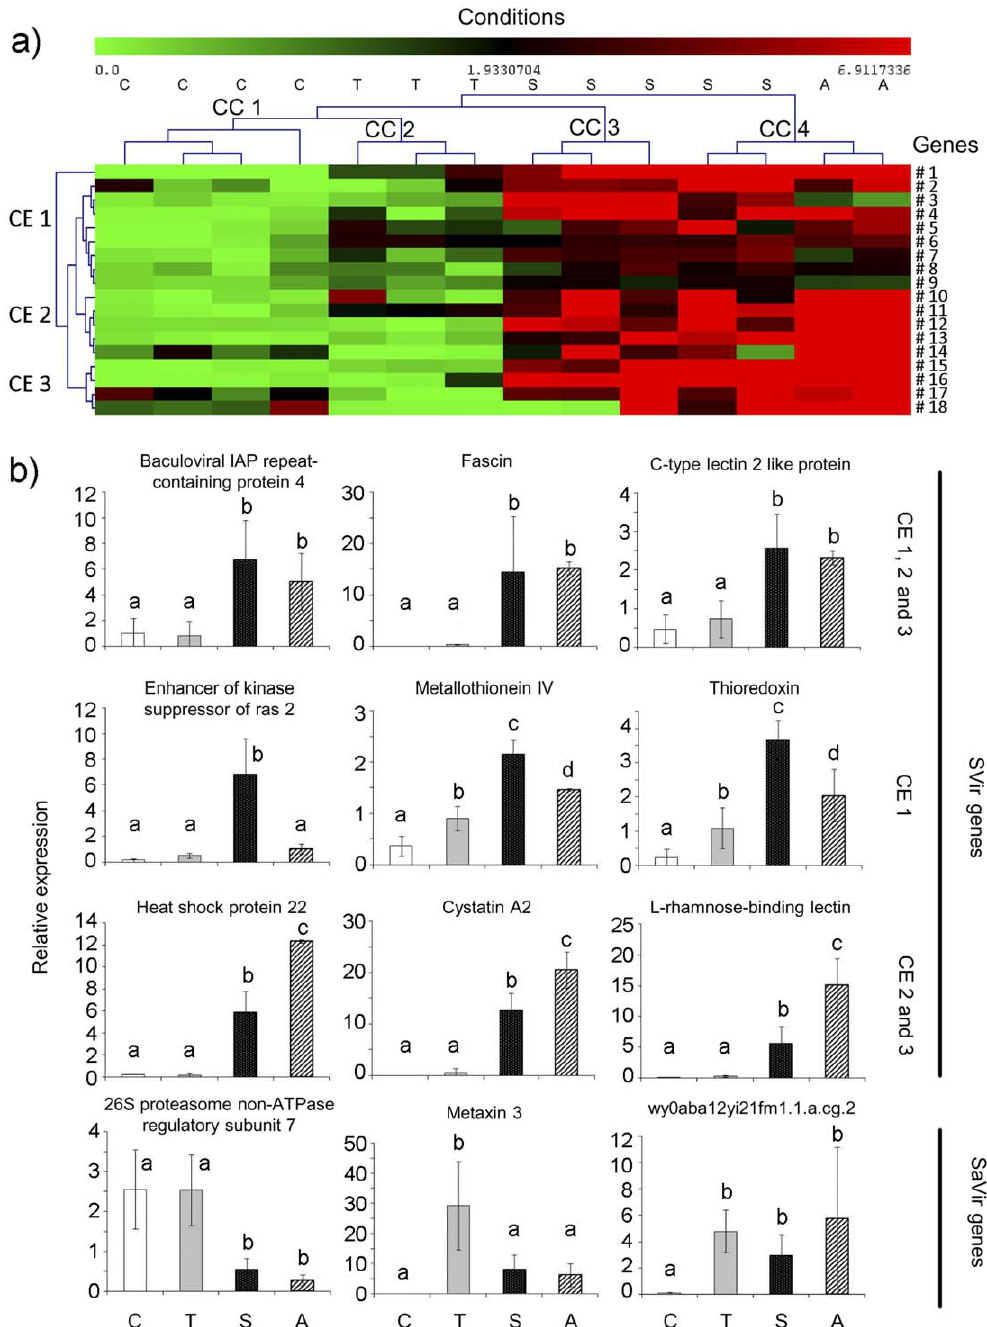
Figure 2. Gene expression analysis by qPCR. (a) Hierarchical clustering analysis and differential expression of 18 genes from SVir library. Hemocyte gene expression profiles were analysed in biological replicates from oysters: non injected as control (C), surviving infections with avirulent V. tasmaniensis LMG 20012 T (T), with virulent V. splendidus LGP32 (S) and virulent V. aestuarianus LPi 02/41 (A). Each biological replicata was constituted by a pool of hemocyte RNA from ten oysters, and between 2 and 5 replicates were analysed for each experimental condition. Each cell in the matrix corresponds to the expression level of one gene in a sample. The intensity of the color from green to red indicates the magnitude of differential expression (see color scale at the bottom of the image). Relative expressions were calculated according the 2 2 ( DD Ct) method normalized with elongation factor-1 a (EF-1 a ). Each value was calculated in reference to the mean of D Ct of all conditions (relative expression=1). The dendrograms at the top of the figures indicate relationship among experimental conditions which define clusters of conditions (CC). The dendrograms at the left of the figures indicate relationship among the profiles of the selected genes which define clusters of expression (CE), after clustering analysis using Multiple Array Viewer software. Gene # 1: Inhibitor of apoptosis; # 2: Baculoviral IAP repeat-containing protein 4; # 3: Enhancer of kinase suppressor of Ras2; # 4: Rac GTPase-activating protein1; # 5: Proteasome 216S subunit, non-ATPase 11a; # 6: Glyceraldhyde 3- phosphate dehydrogenase; # 7: Thioredoxin; # 8: C-type lectin 2 like protein; # 9: Metallothionein IV; # 10: F-box only protein37; # 11: Cystatin B-like protein; # 12: Heat shock protein 22 isoform 1; # 13: L-rhamnose-binding lectin; # 14: Microsomal glutathione S-tranferase; # 15: Cystatin A; # 16: Interferon-induced protein 44; # 17: Cullin-associated and neddylation-dissociated 1. Hierarchical clustering was contructed with Multiple Array